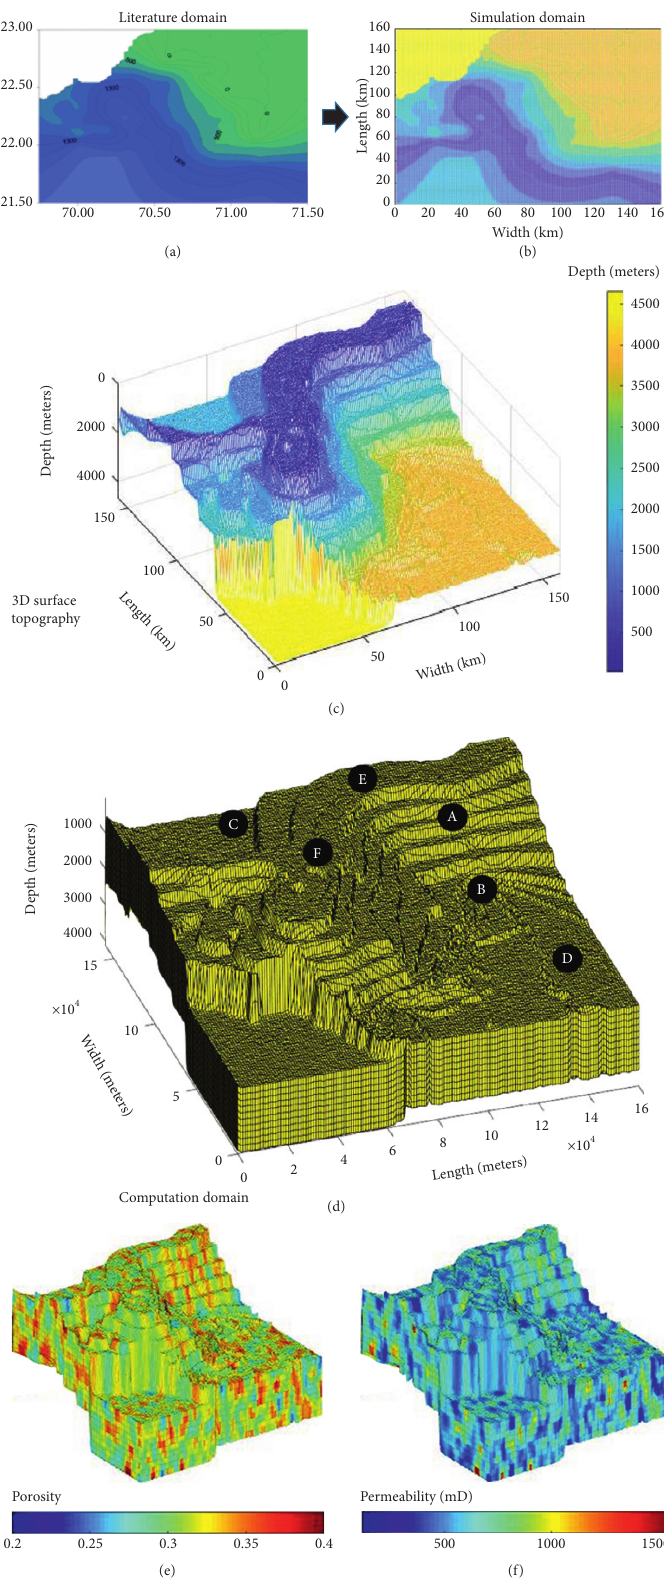
Figure 2: The illustration of (a) contour plot, showing the thickness of the Deccan trap in Saurashtra region, Gujarat [19]; (b) numerically modeled synthetic simulation domain; (c) three-dimensional view of simulation domain; (d) 3D discretization after upscaling and discrete points, representing the CO 2 injection points; (e) the porosity; and (f) permeability variation of the synthetic domain considered for CO 2 geologic sequestration